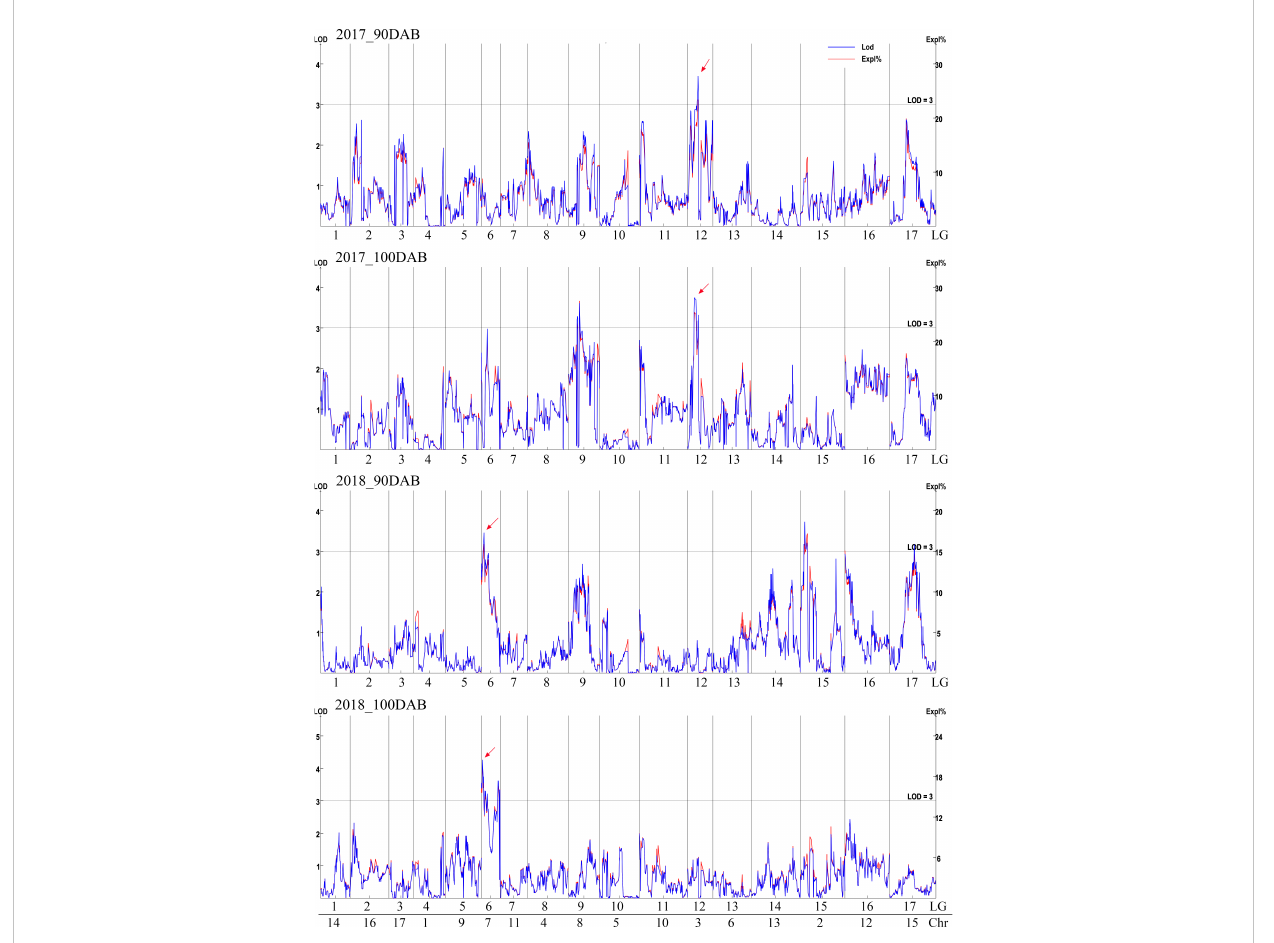
FIGURE 2 QTL analysis of total sugar content in 2017 and 2018. The logarithm of odds (LOD) value is shown on the left y-axis, and the explained variance (Expl %) is on the right y-axis.